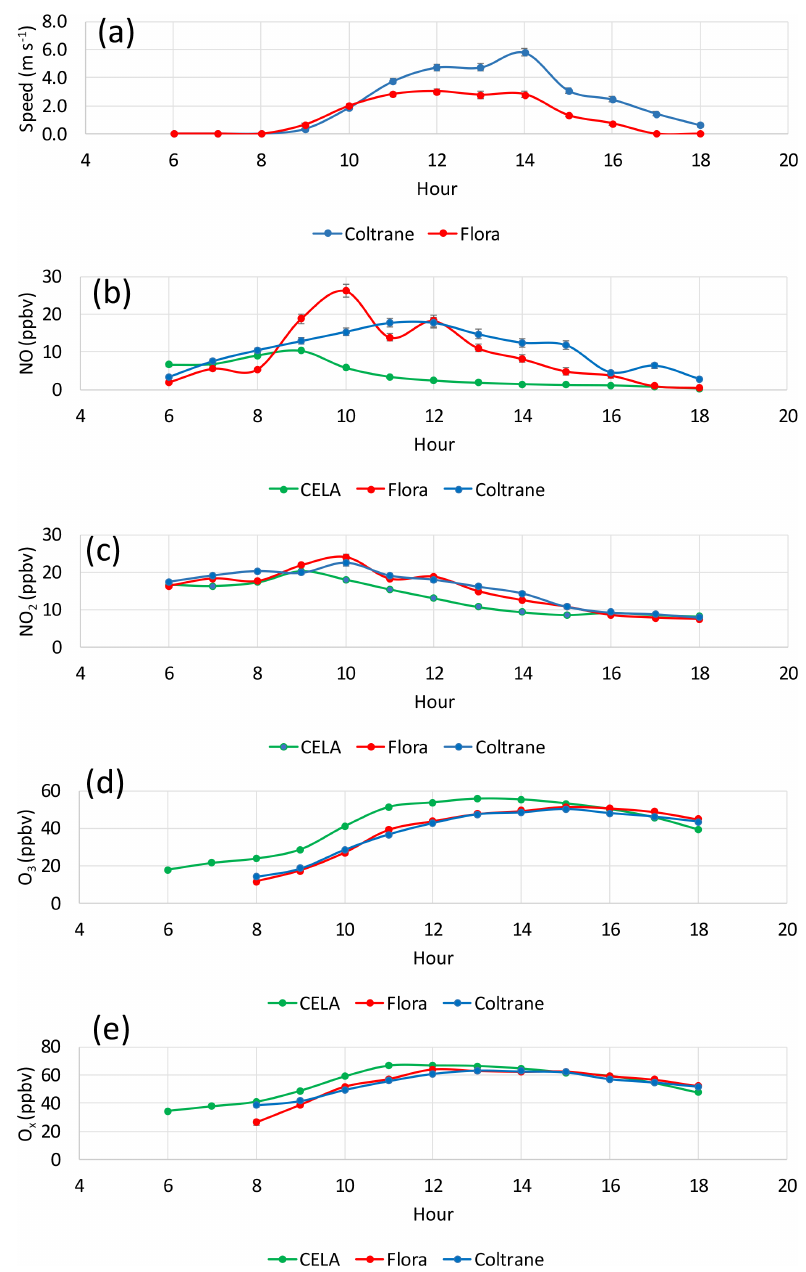
Figure 2. Mean vehicle speeds and pollutant concentrations averaged by hour over all Los Angeles driving days between 3 and 12 Au- gust 2016. Standard errors of the means are plotted but are generally smaller than the symbol